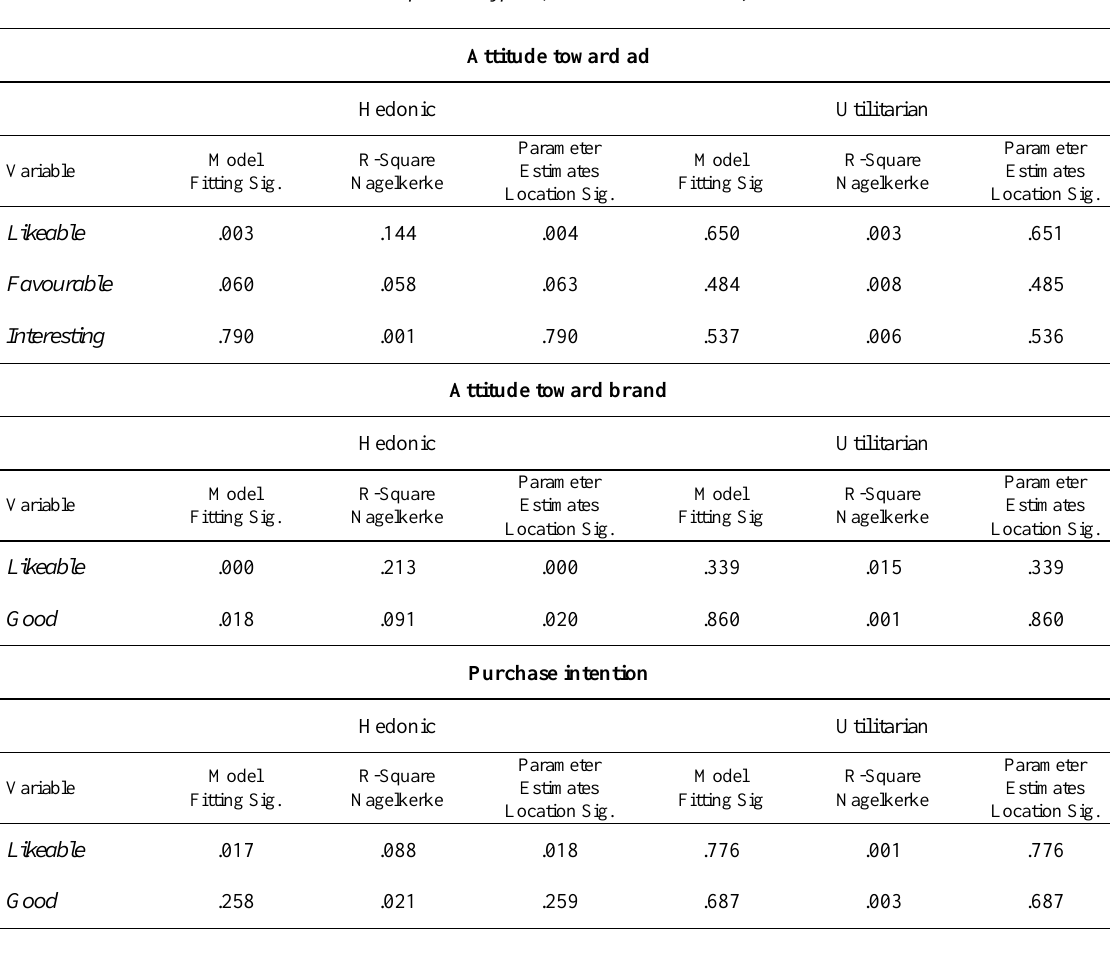
Table 2. Mediating effect of typeface figuration on attitude and intention dimensions